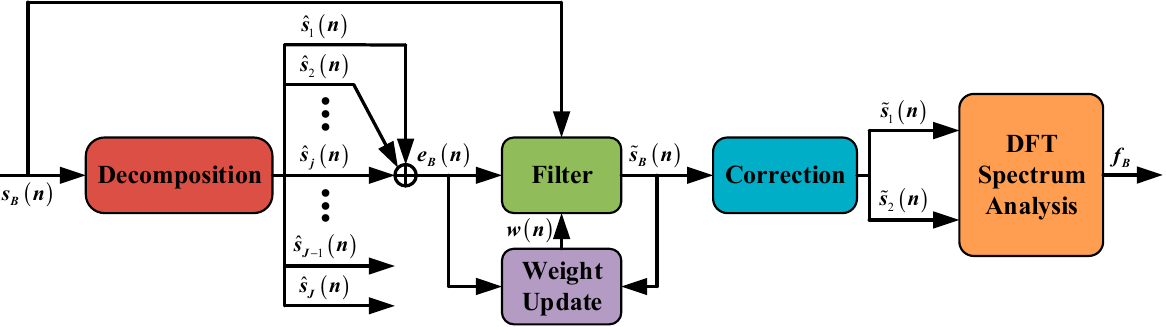
Figure 4. Process of DFBDWC algorithm. The input and output of this algorithm are the beat signal and frequency value of the beat signal, respectively.